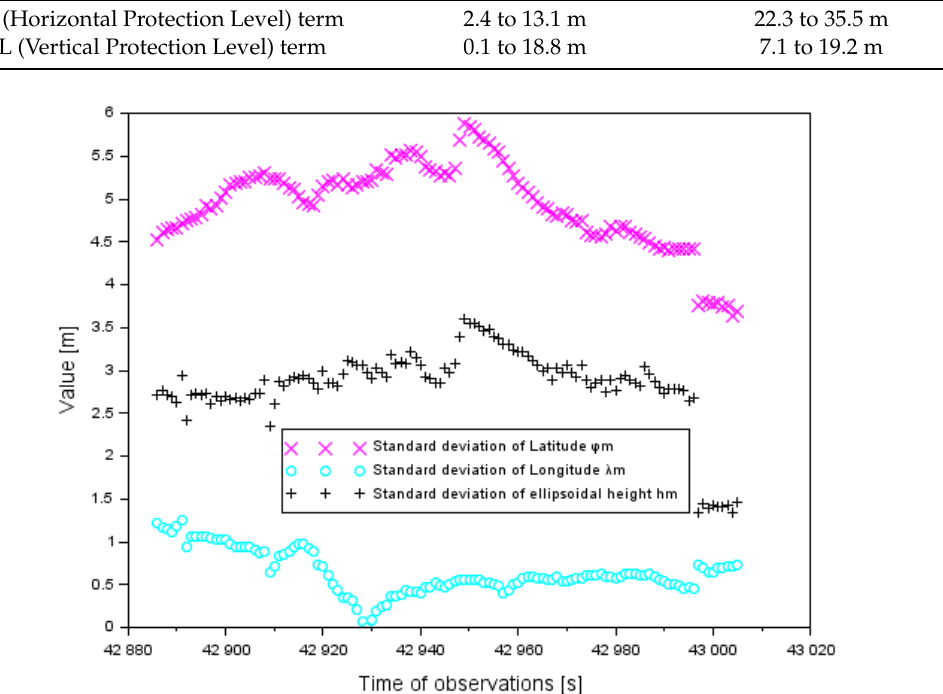
Figure 8. Standard deviation of an average aircraft position in the air test in Che ł m.